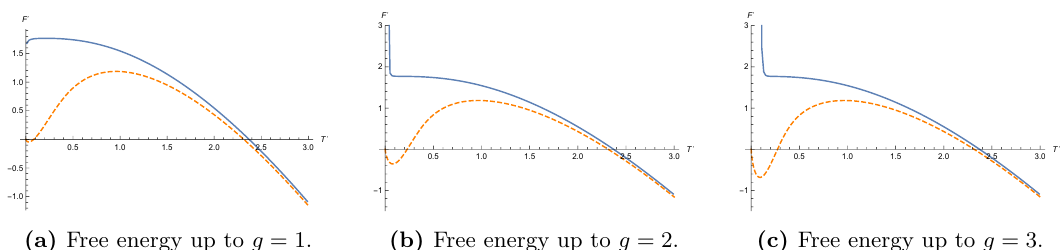
Figure 2. Plot of free energy including the higher genus corrections up to (a) g = 1 , (b) g = 2 and (c) g = 3 . The blue solid curves are the quenched free energy in (3.50) while the orange dashed curves represent the annealed free energy − T 0 log h Z i [ g ]